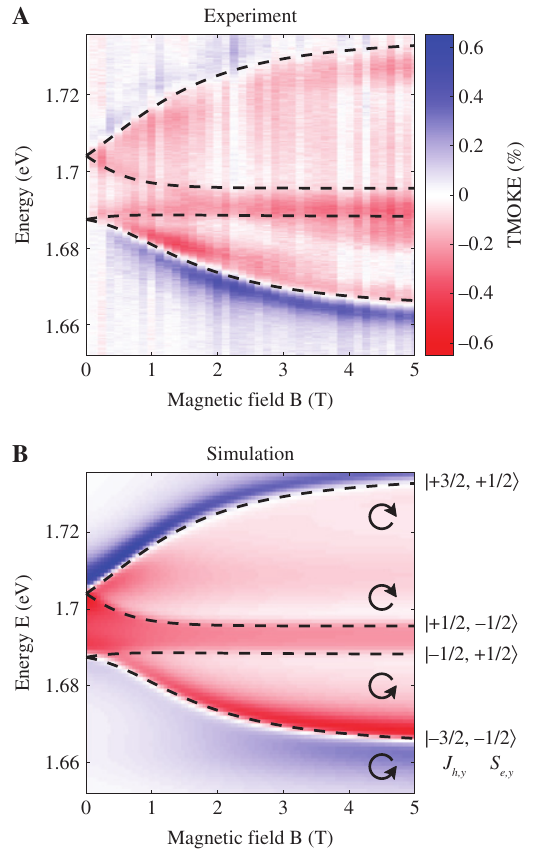
Figure 5: TMOKE in the excitonic spectral range in the strong coupling regime Δ / Γ > 1: (A) measured and (B) calculated energy and magnetic field resolved TMOKE spectra for θ = 5 ° at T = 1.6